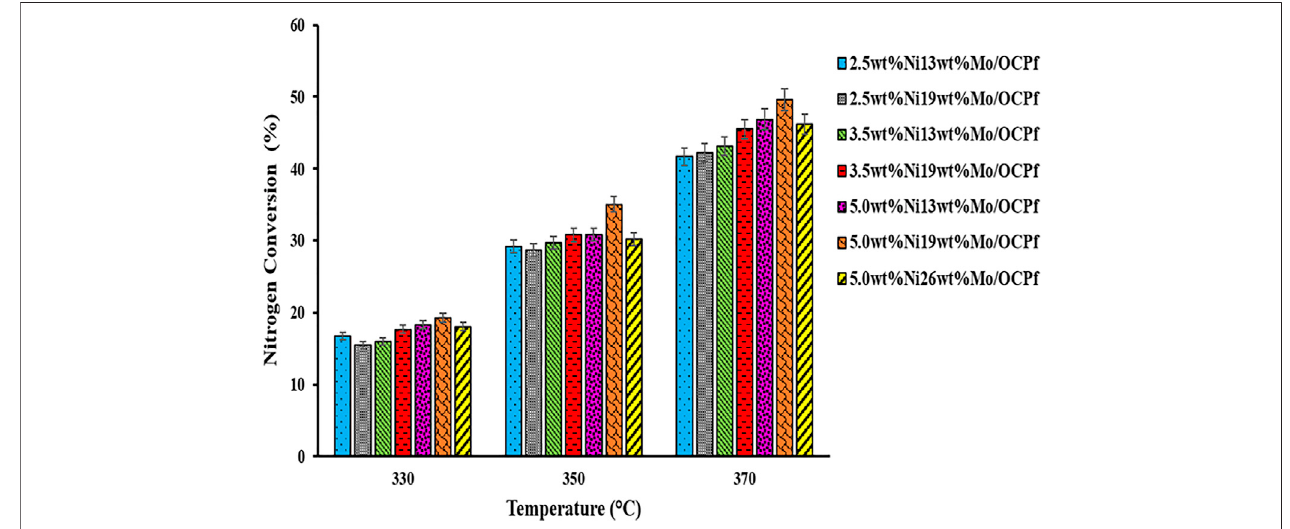
FIGURE8 | HDNactivitiesof NiMo/OCP f catalysts with LGO at 330, 350, and 370 ° C (Catalyst (cid:2) 5 cm 3 ,LHSV (cid:2) 2h − 1 , P (cid:2) 9.0 MPa, and H 2 /oil ratio (cid:2) 600 (ml/ml)).